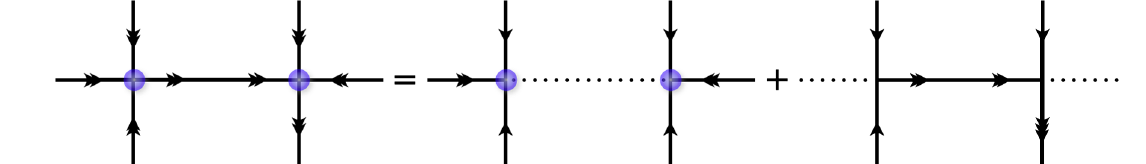
FIG. 7. Divergence-full and divergence-free field distributions for two isolated nearest-neighbor north poles (particle 1 on the left and 2 on the right) for the dumbbell model on a square lattice. Each chevron corresponds to a magnetic-moment field strength of m= 2 a and a dotted line to zero-field strength. The blue circles represent north poles of charge 2 m=a